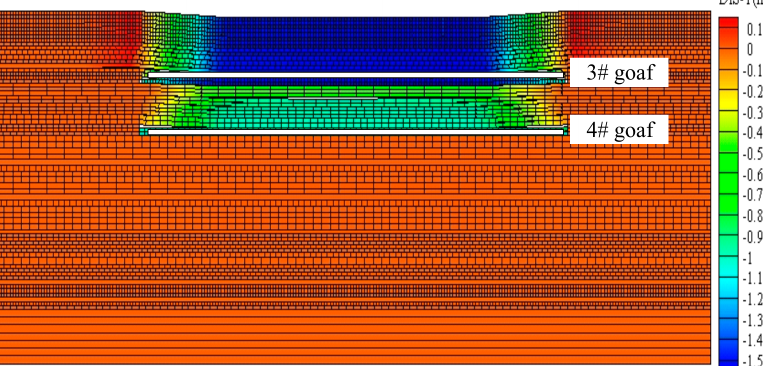
Figure 19. Displacement field of overburden after the mining of the 4# coal